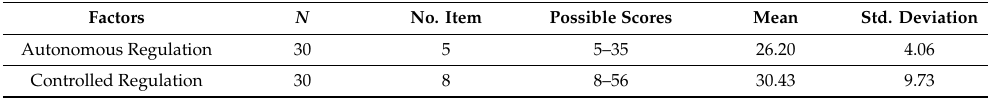
Table 7. Means, standard deviations, ranges, and sample sizes for autonomous regulation and controlled regulation.